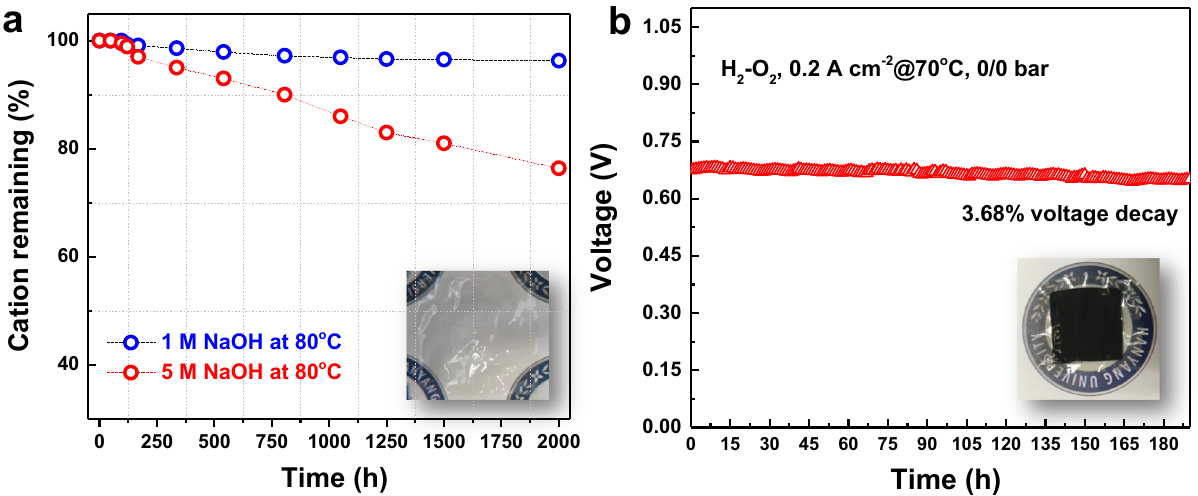
Fig. 6 Ex-situ and in-situ durability. a Remaining cations (%) of PFTP-13 AEMs at different concentrations of NaOH (1 and 5 M) at 80 °C for 2000 h detected by 1 H NMR, along with the picture of membrane after alkaline treatment in 1 M NaOH for 2000 h. 3% and 22% loss in ion conducting groups (piperidinium) was detected by 1 H NMR testing after immersion in those alkaline solutions. b In-situ durability of H 2 – O 2 AEMFCs based on PFBP-14 AEIs and PFTP-13 AEMs testing at a 0.2 A cm − 2 current density at 70 °C with a 200/200 mL min − 1 A/C fl ow rate and 90/100% A/C RH, along with the picture of CCM after in-situ durability